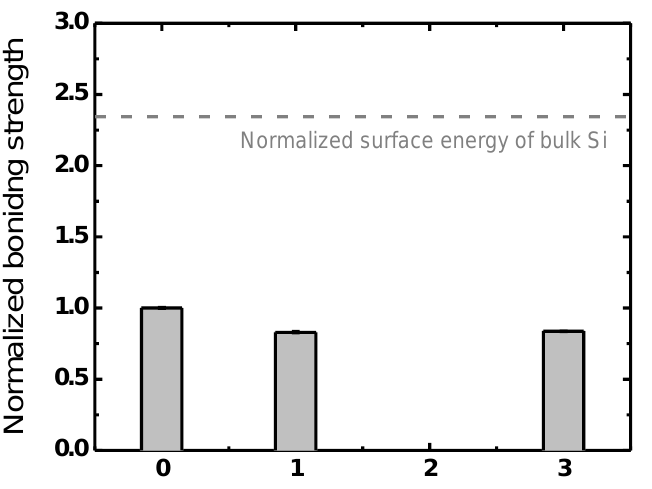
Figure 12. Bonding strengths obtained with different pause durations between prebonding and annealing normalized to the bonding strength with no plasma treatment.